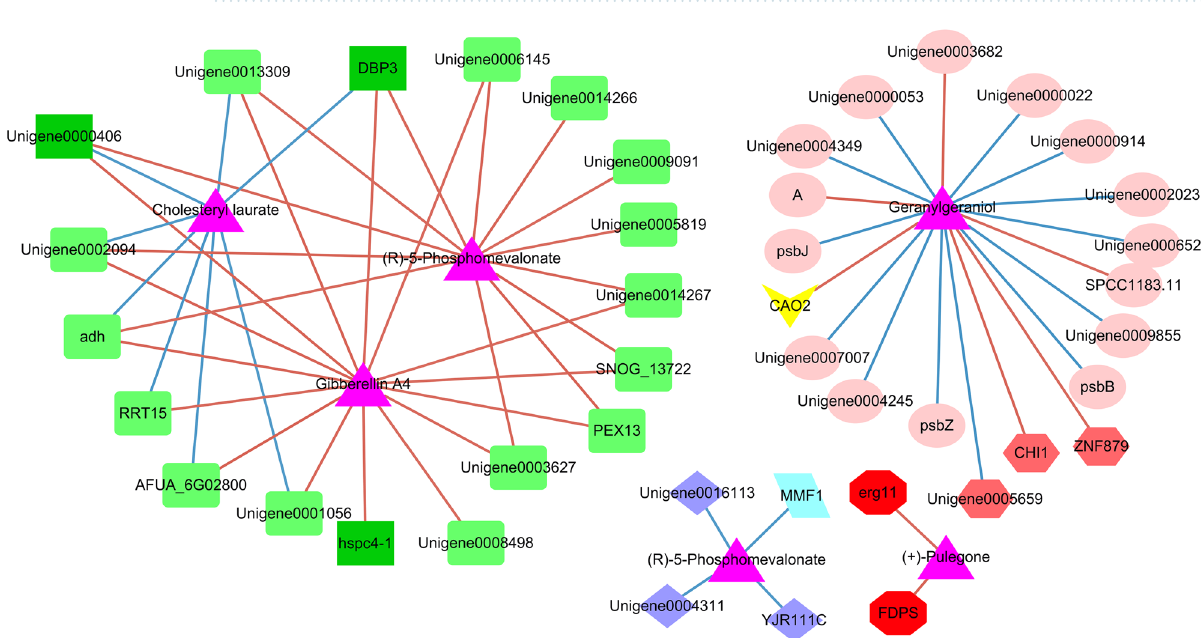
Figure 6. Correlation between DEGs and differential metabolites. Names or number of DEGs and metabolites are marked on the node graph. Magenta triangles represent metabolites; light green boxes represent genes with opposite expressions by STEM analysis; dark green boxes represent regulatory factors and genes with opposite expressions; dark red hexagons represent regulatory factor genes; light blue parallelograms represent regulatory genes; bright red octagons represent regulatory genes in related pathways; yellow V shapes represent genes in related pathways of triterpenoid synthesis. Red lines indicate a positive correlation, while blue lines indicate a negative